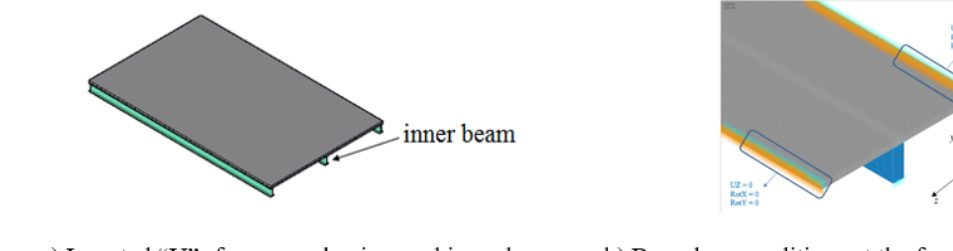
Figure 3. Inverted “U”- frame mechanism analyzed in this